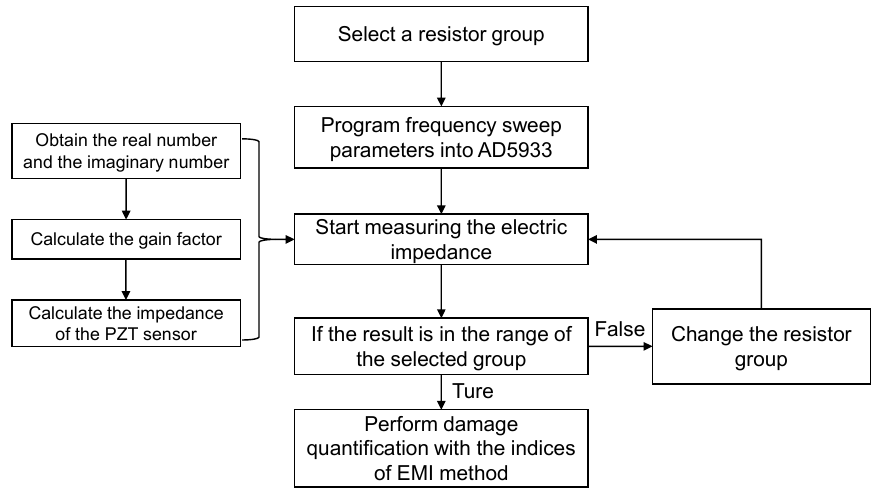
Figure 10. The flowchart of damage detection with impedance measurement.